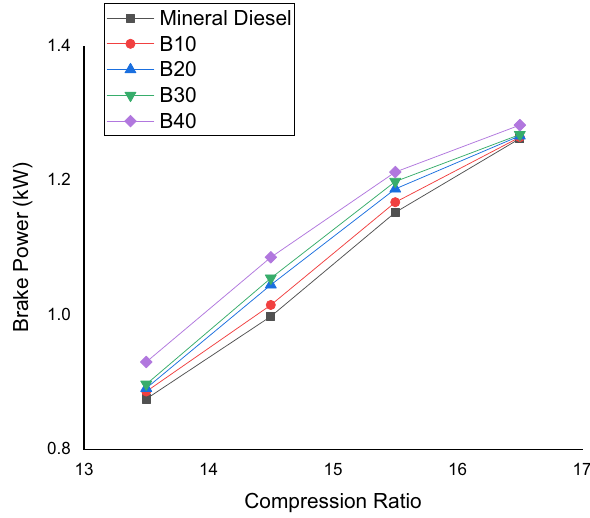
Fig. 5 Variation of BP of dual biodiesel sample blends at different compression